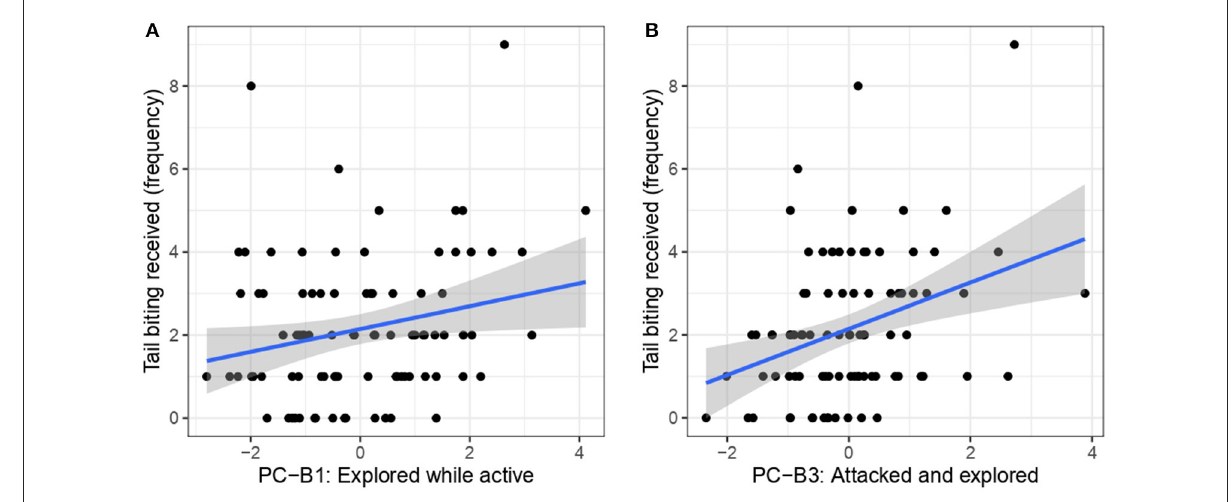
FIGURE3 The relationship of tail biting received to PC-B1 “Explored while active” (A) and PC-B3 “Attacked and explored” (B) .